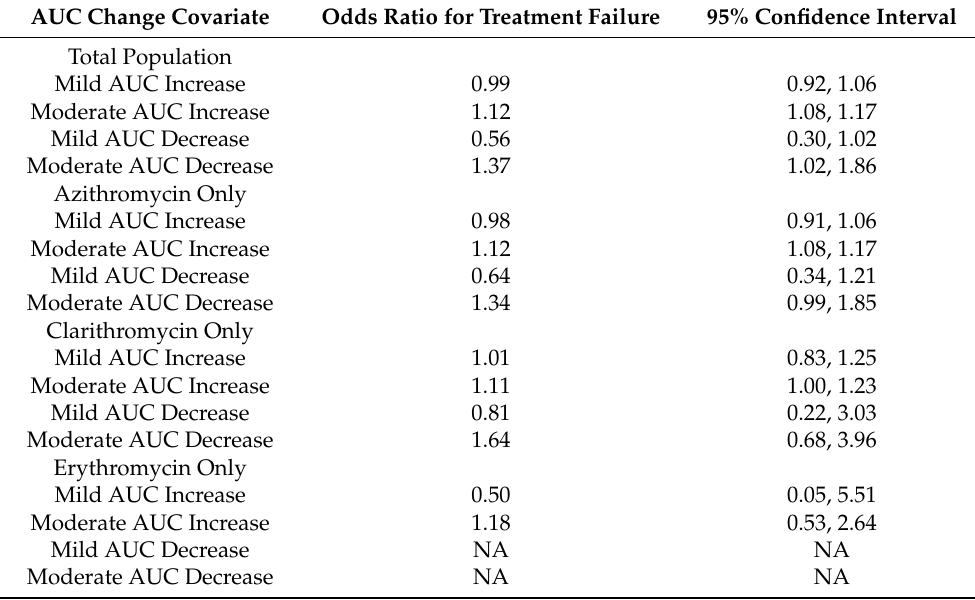
Table 5. Summary of the calculated odds ratios and 95% confidence intervals for risk of treatment failure in the common acute infection analysis with respect to AUC change versus no AUC change due to DDI. Statistical significance of the odds ratio estimate was confirmed if the 95% confidence interval did not cross a value of 1.